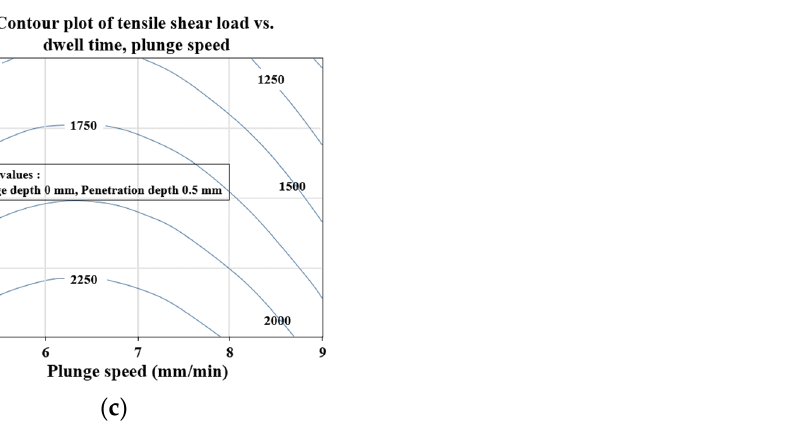
Figure 5. Contour plots of tensile shear load. ( a ) Penetration depth and plunge speed; ( b ) penetration depth and dwell time; ( c ) dwell time and plunge speed.